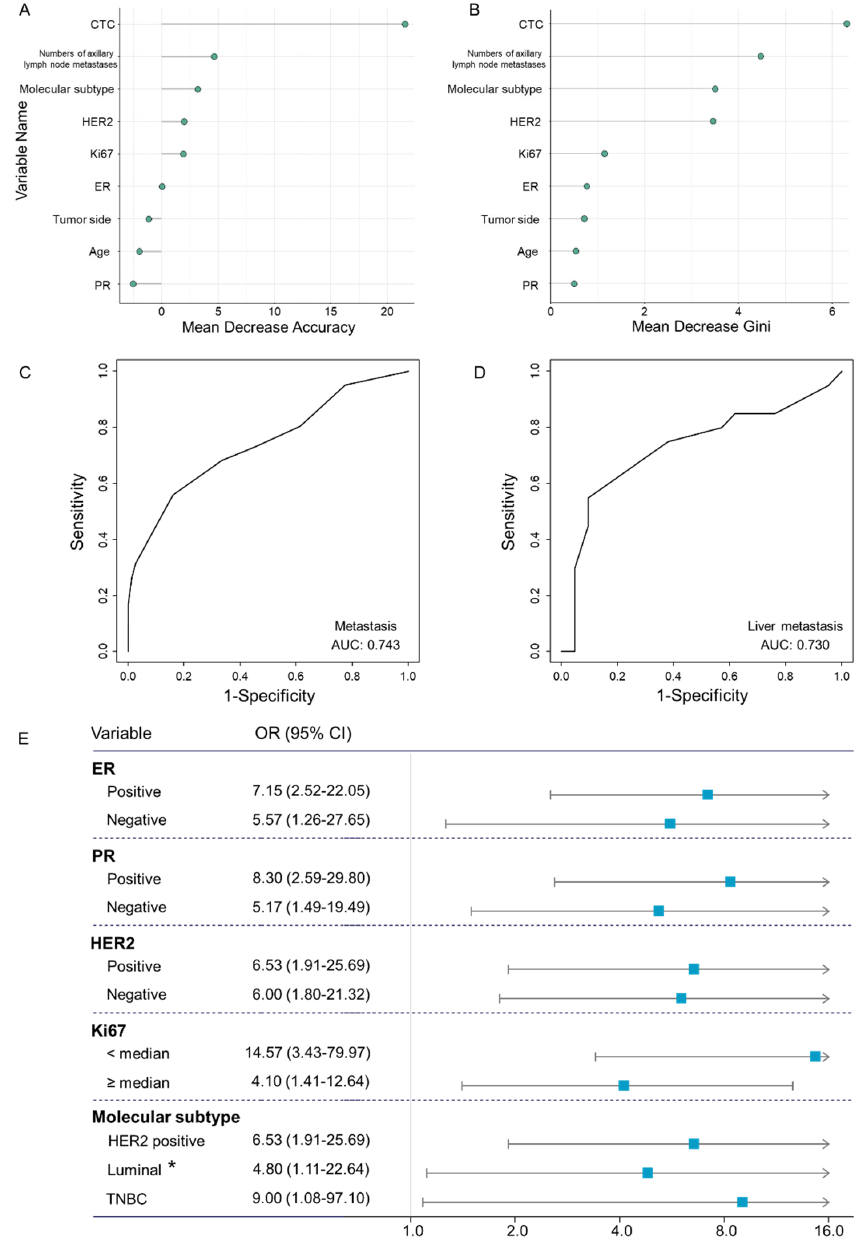
Figure 2. The evaluation of variable importance and diagnostic performance. A random forest algorithm was used to calculate ( A ) mean decrease accuracy and ( B ) mean decrease Gini score. A higher mean decrease accuracy and mean decrease Gini index indicates a more important association be- tween the variable and tumor metastasis. CTC enumeration showed the highest variable importance with a mean decrease accuracy of 21.5 and a mean decrease Gini score of 6.4. Receiver operating characteristic curve of CTC enumeration for ( C ) tumor metastasis in patients with breast cancer and ( D ) liver metastasis in patients with metastatic breast cancer. ( E ) Forest plot of sensitivity analysis for the positive association between CTC enumeration and tumor metastasis across ER (positive or negative), PR (positive or negative), HER2 (positive or negative), Ki67 (< median or ≥ median), and molecular subtypes (HER2 positive, luminal, or triple-negative breast cancer). The odds ratios with 95% confidence intervals were calculated and the group of CTCs < 5 was set as the reference. * means Luminal A and B with HER2-negative. Abbreviation: AUC—area under the curve; CI—confidence